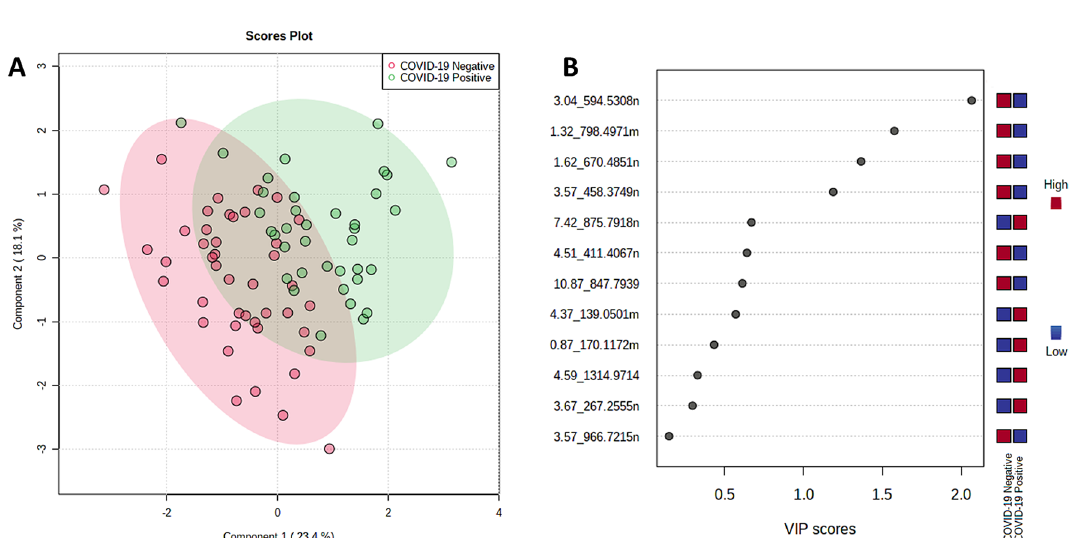
Figure 6. ( A ) PLS-DA plot and ( B ) high VIP score metabolites for sebum, COVID-19 positive versus COVID- 19